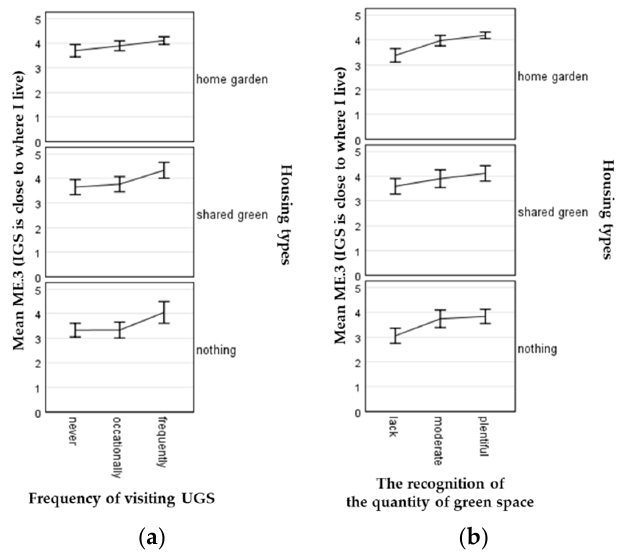
Figure 8. Exploring independent variable effects on ‘ME.3’ (Error bars: 95% CI). ( a ) Frequency of visiting UGS for different housing types; ( b ) perceived quantity of green space for different housing types.